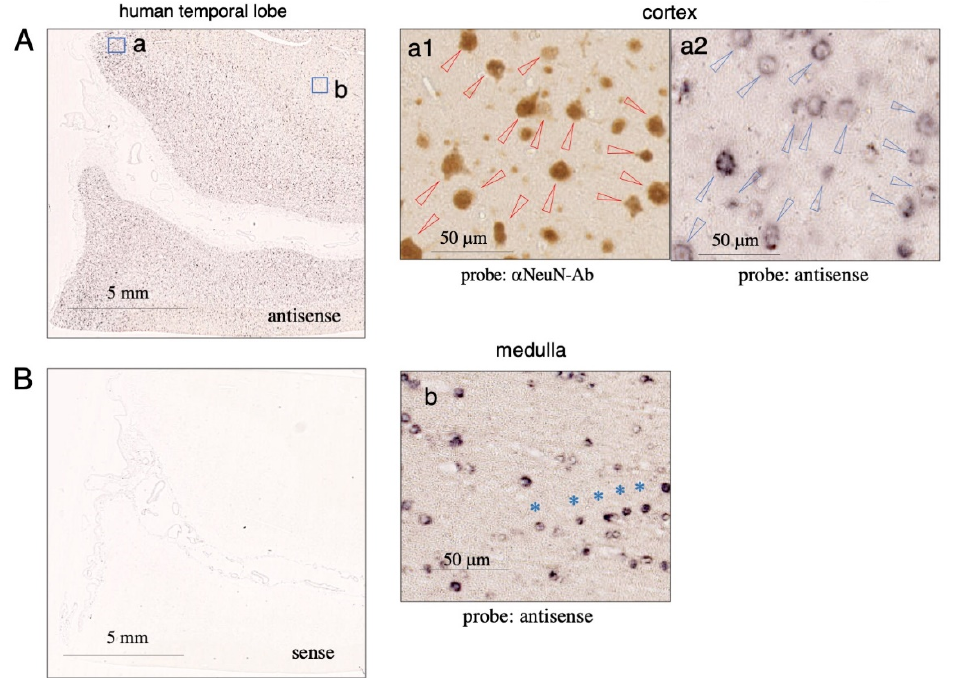
Figure 5. Expression of Tf mRNA in human brain tissue . Human brain sections were subjected to in situ hybridization using DIG ‐ labeled antisense ( A ) or sense probes ( B ). The probe was detected with